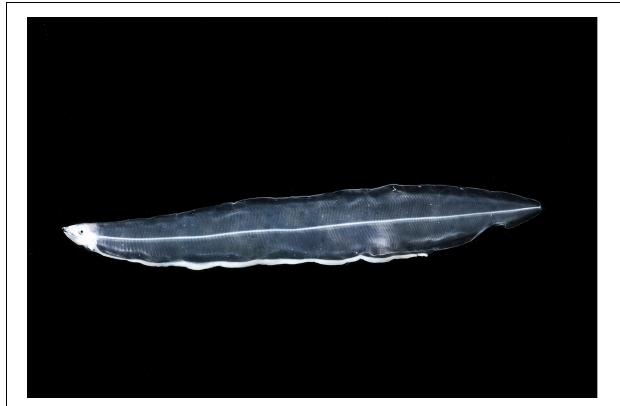
FIGURE 4 | Muraenidae leptocephalus morphotype Gymnothorax sp.1 JAM. Collected 11 May 2017 at station B175D in the 0–200 m stratum. Specimen was 51 mm SL. Photo by Dante Fenolio.